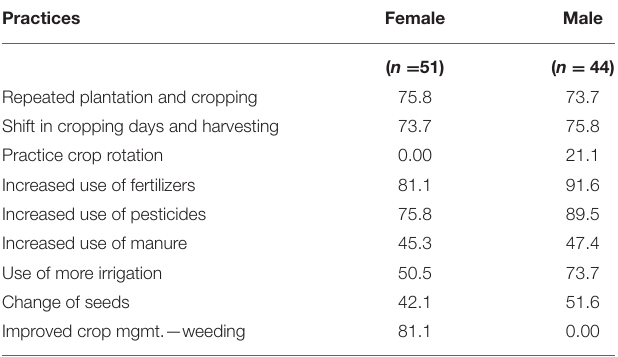
TABLE 1 | Adaptation practices of households to deal with the impacts of climate variability on agriculture in Kailali district (% response of respondents). Practices